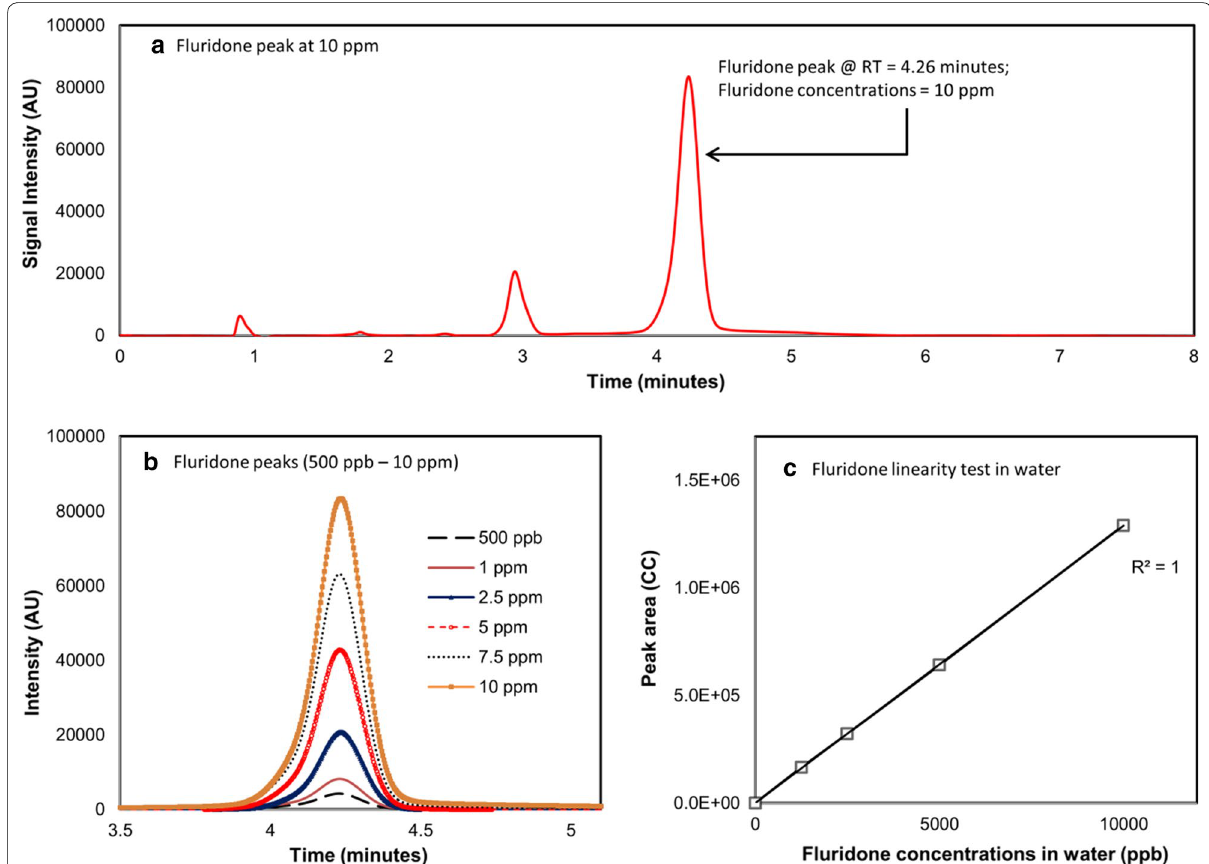
Fig. 1 Fluridone detection in water samples: a fluridone peak at 10 ppm; b fluridone peaks at 500 ppb–10 ppm; and c Relationship between fluridone concentrations in water and peak